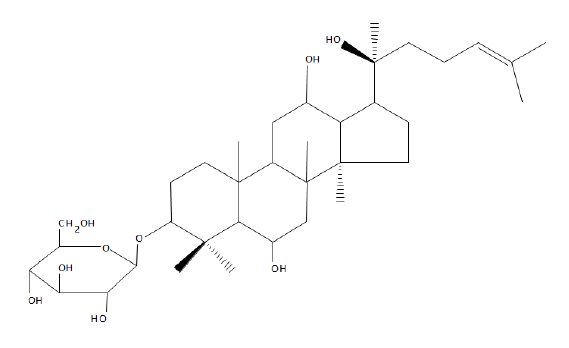
Figure 1: The chemical structure of ginsenoside Rh